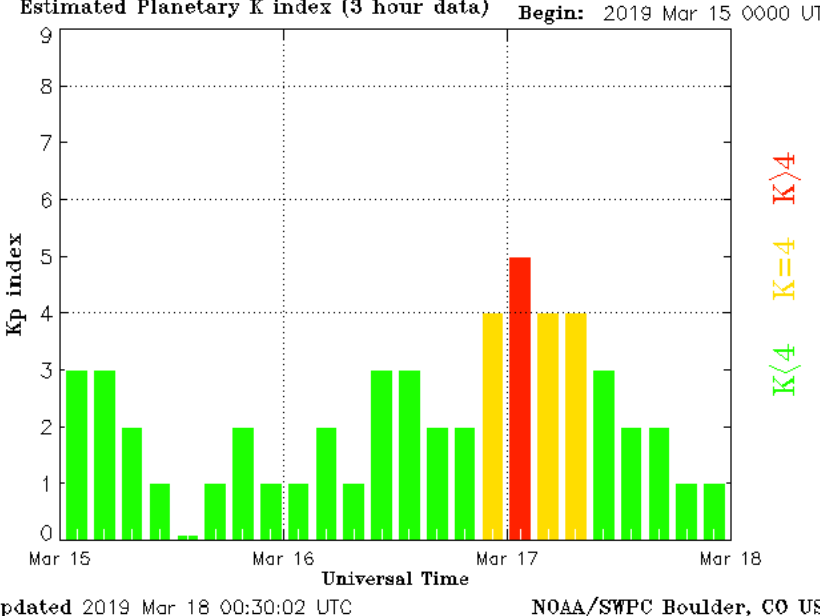
Figure 18. Estimated planetary index during the time the Ten-Koh anomaly occurred on 19 March 2019 (showed with the red